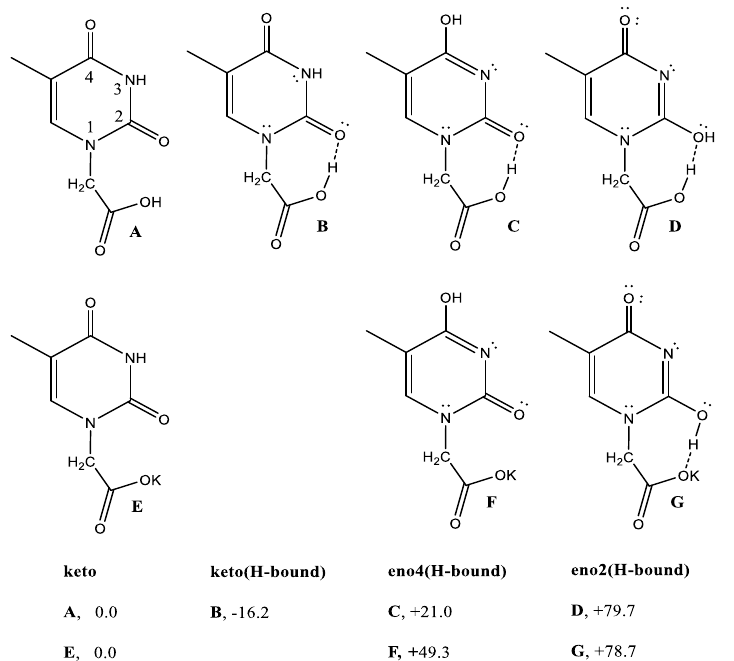
Scheme 7. Calculated free energies (kJmol − 1 ) for the equilibrium between THAcH ( A – D ) and anionic THAcK ( E – G ) amido and imino-enol tautomers.